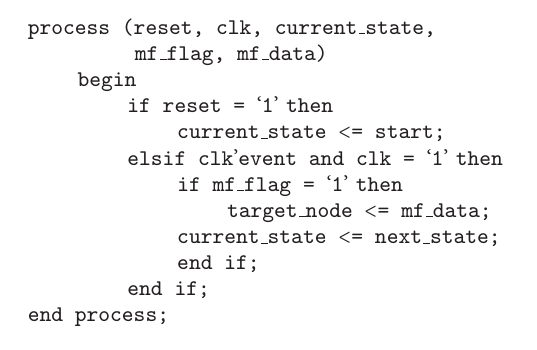
Algorithm 2: VHDL code on the FPGA